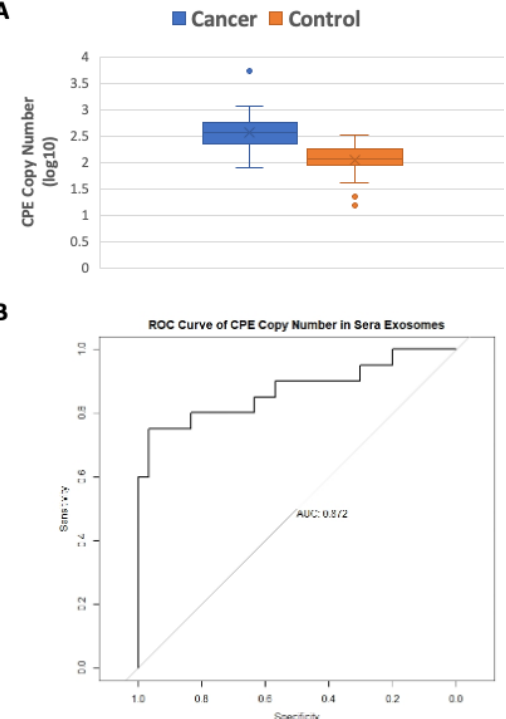
Figure 3. Serum exosomes from cancer patients are enriched in CPE mRNA. ( A ) Box plot showing the log-transformed data of CPE copy numbers in sera exosomes derived from 20 cancer patients versus 30 healthy subjects ( p = 0.0007). ( B ) ROC curve of CPE copy numbers in exosomes from cancer patients’ sera compared to control sera, showing the AUC. Types of cancer included (in cases): Breast cancer (n = 5), Ovarian cancer (n = 5), Glioblastoma (n = 5), Colon cancer (n = 1), Cervical cancer (n = 1), Kidney cancer (n = 1), Pancreatic cancer (n = 1) and Prostate cancer (n = 1). Quantitation of CPE mRNA copy numbers was perfomed by standard curve method using CPE 5 ′ -DNA fragment of known concentration. Logistic regression and receiver operating characteristics (ROC) curve analysis was used to determine the association of cancers with CPE copy number in sera